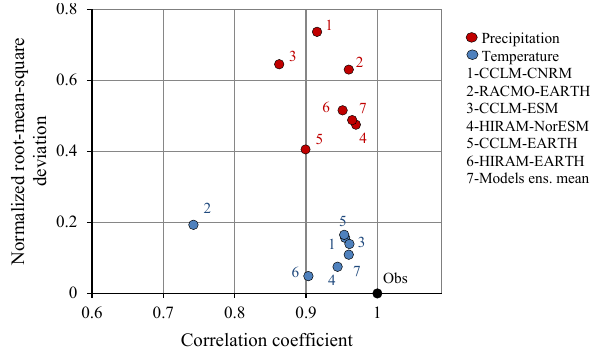
Figure 3. Statistics of RCM–GCM based precipitation and tempera- ture compared to observations (Obs) for the reference period (1971– 2000). Climate model data are not bias corrected. Statistics are com- puted based on average monthly